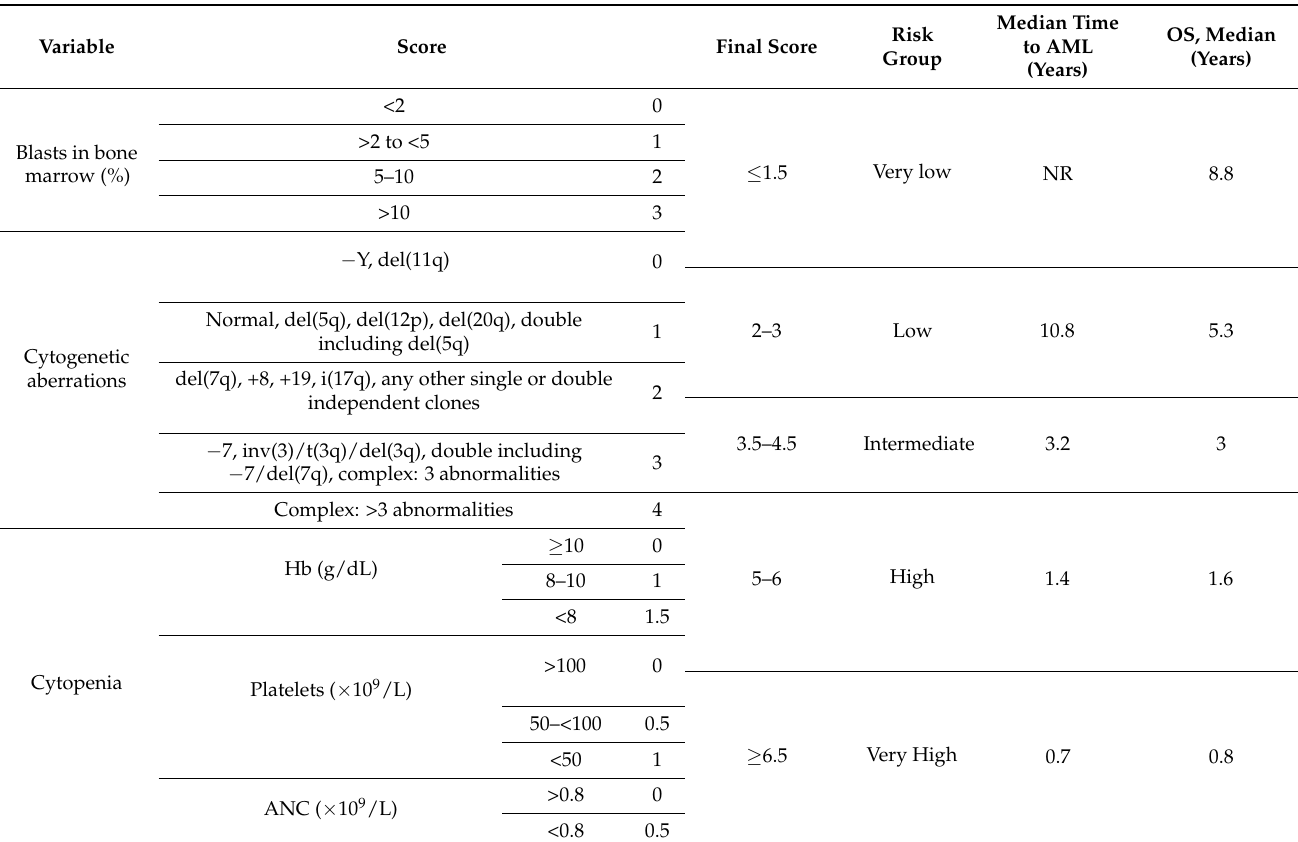
Table 4. Revised IPSS. Adapted from Greenberg et al., Blood, 2012